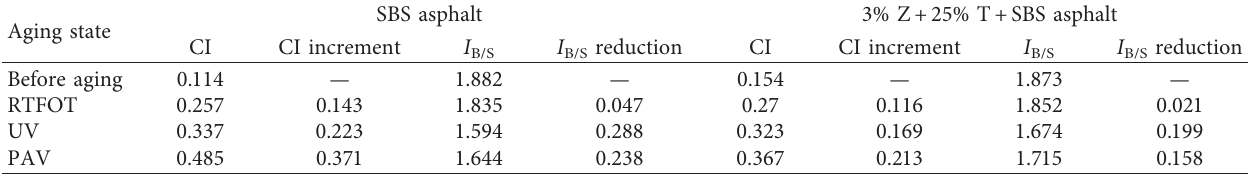
B/S ) before and after aging.